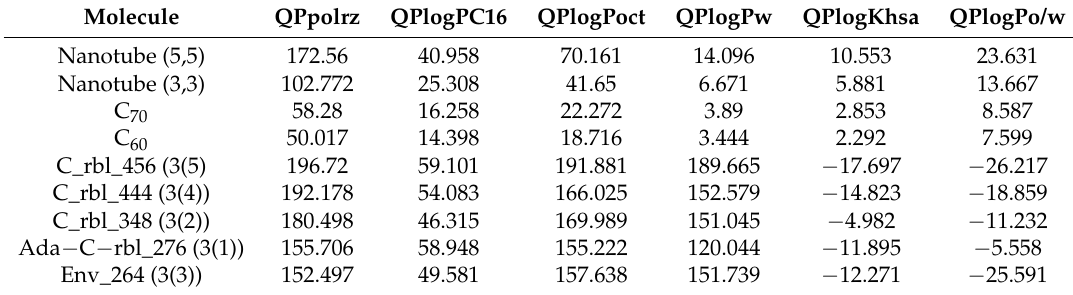
Table 4. Hydrophilic/lipophilic partition related descriptors: QPpolrz − predicted polarizability in QPlogPoct − predicted octanol/gas partition coefficient